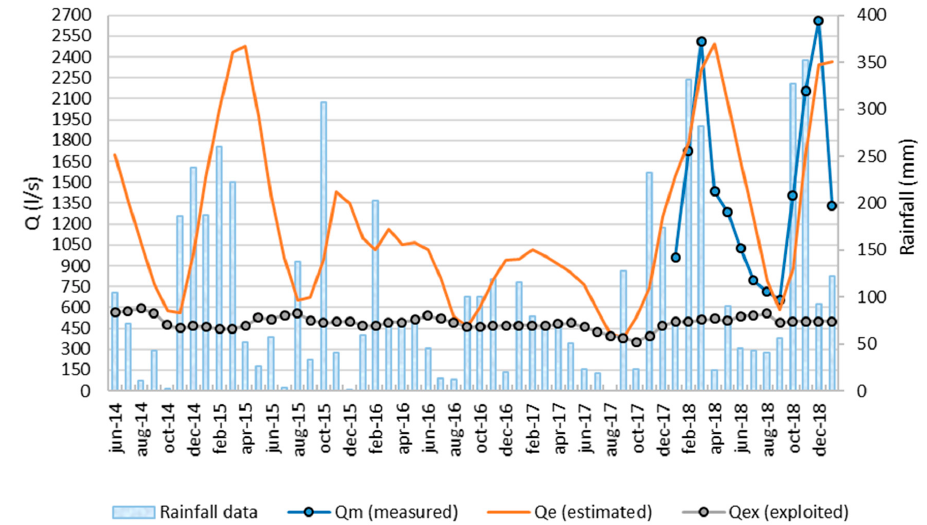
Figure 8. Validation time window: Comparison between model estimated ( Q e ), measured ( Q m ) discharges for the Capodacqua di Spigno Spring and the flow rate exploited ( Q ex ) by the local water supply agency (Acqualatina S.p.A. – i.e. Corporation).